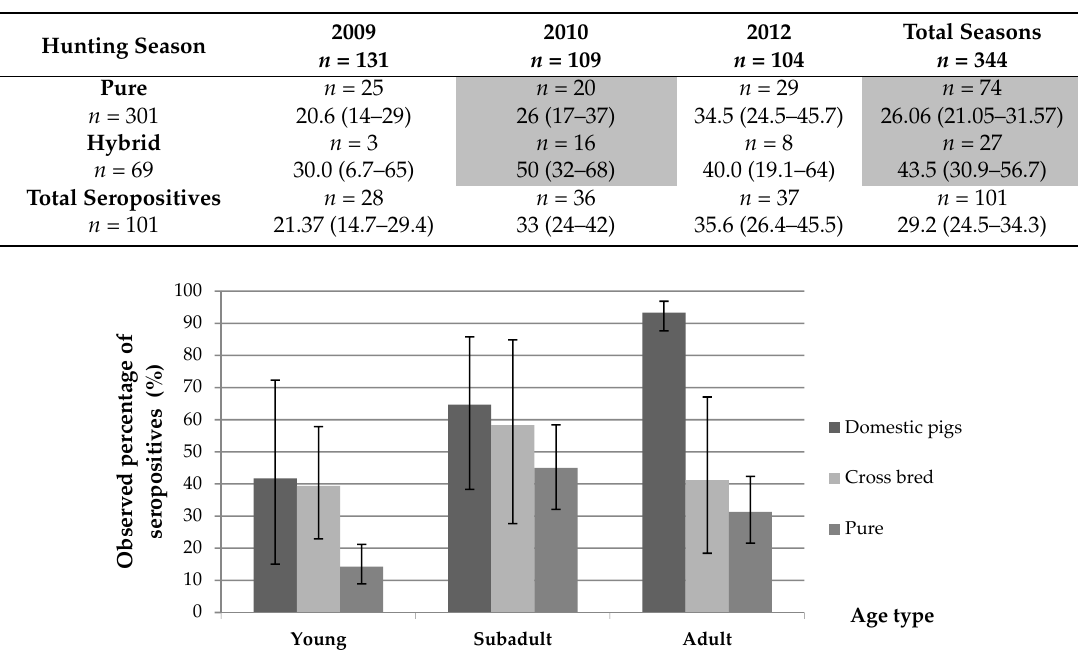
Figure 2. Comparison of seropositivity percentage values in domestic pigs, hybrids and pure wild boars showing a significantly higher prevalence among young hybrid animals ( p = 0.006) when compared with pure wild boar.